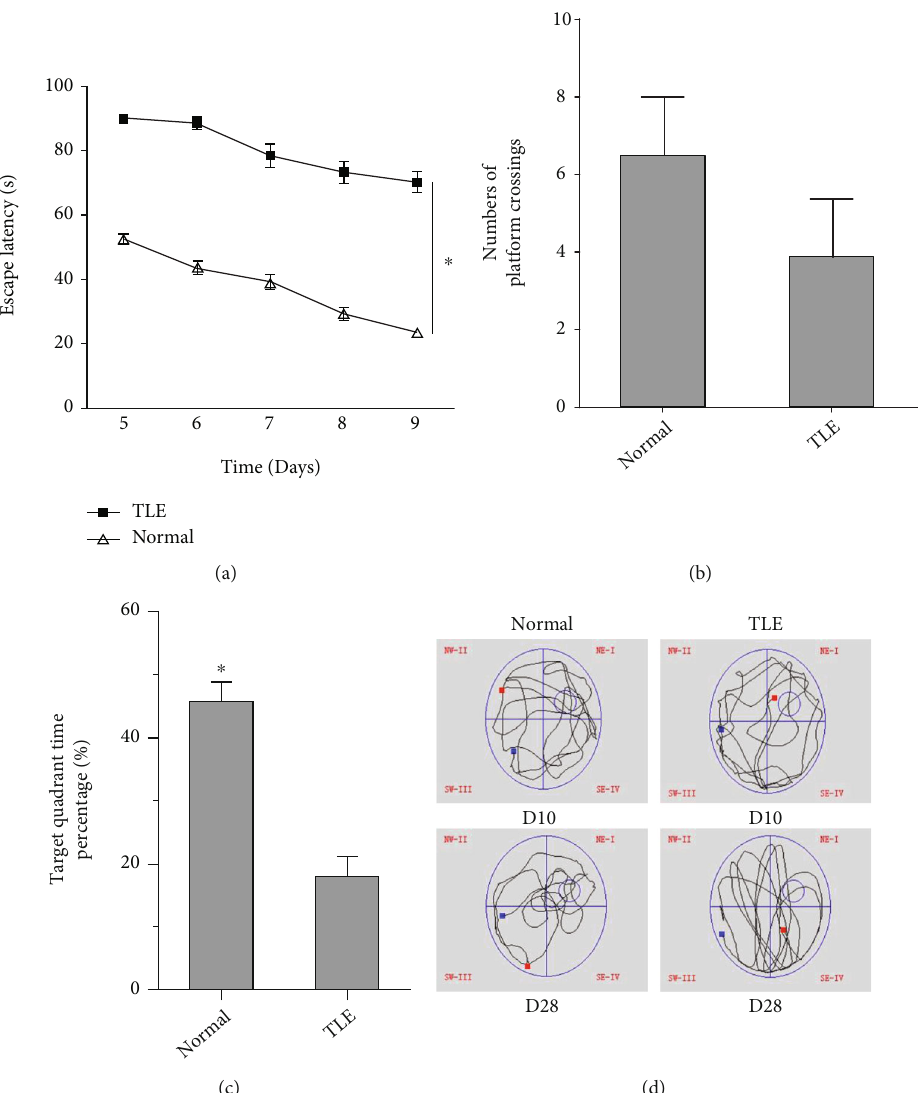
Figure 3: Learning and memory dysfunction of TLE rats. (a – c) Spatial acquisition and probe trial results of normal and TLE rats, as measured by MWM test. (a) Escape latency during the 5 training days (D5-D9) after SE. (b) Numbers of crossing the platform in the probe trial on D10. (c) Target quadrant time percentage in the probe trial on D10. (d) Representative swimming path of each group in the probe trial. The data were represented as mean ± SD . ∗ P < 0 : 05 , vs. the normal